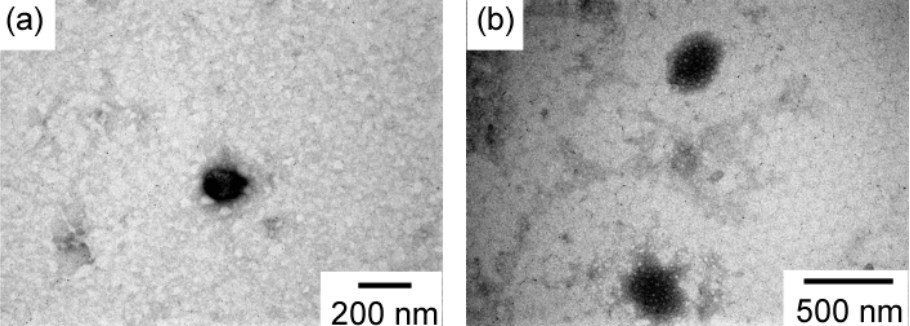
) and in PBS bu ff er (cid:35)